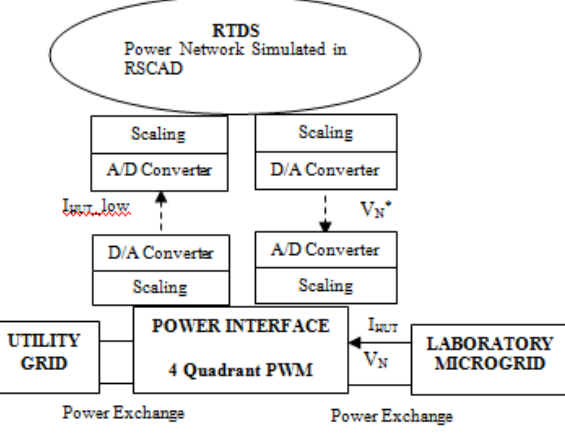
Figure 4. Representation of the PHIL